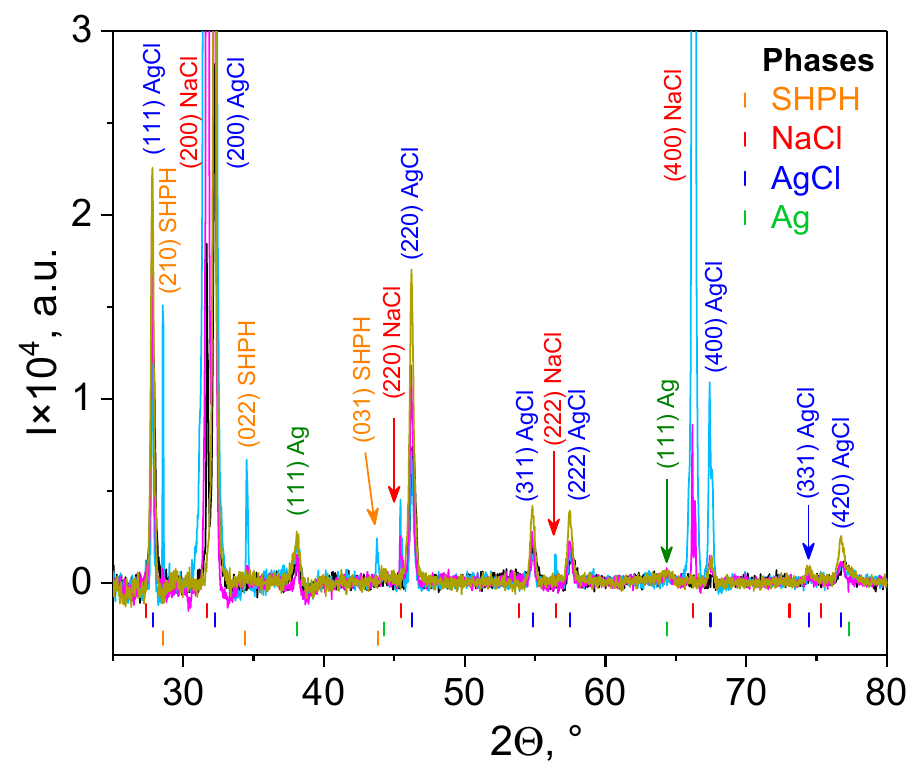
Figure 3. XRD patterns for samples with hybrid Ag/AgCl nanoparticles phytogenerated from nettles and grapes: P3—Ag/AgClNPs (light blue line), P4—Ag/AgClNPs–CTS (black line), P5— Ag/AgClNPs–Liposomes (magenta line) and P6—Ag/AgClNPs–Liposomes–CTS (dark yellow line).